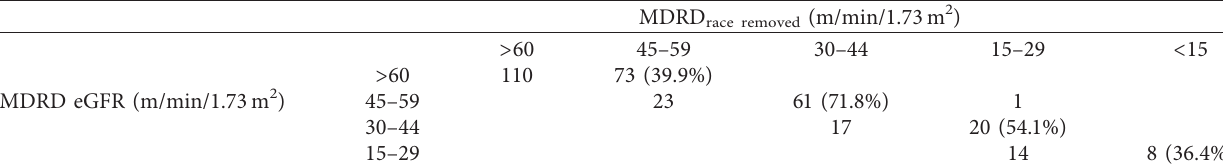
Table 3: Comparison between the MDRD and MDRD